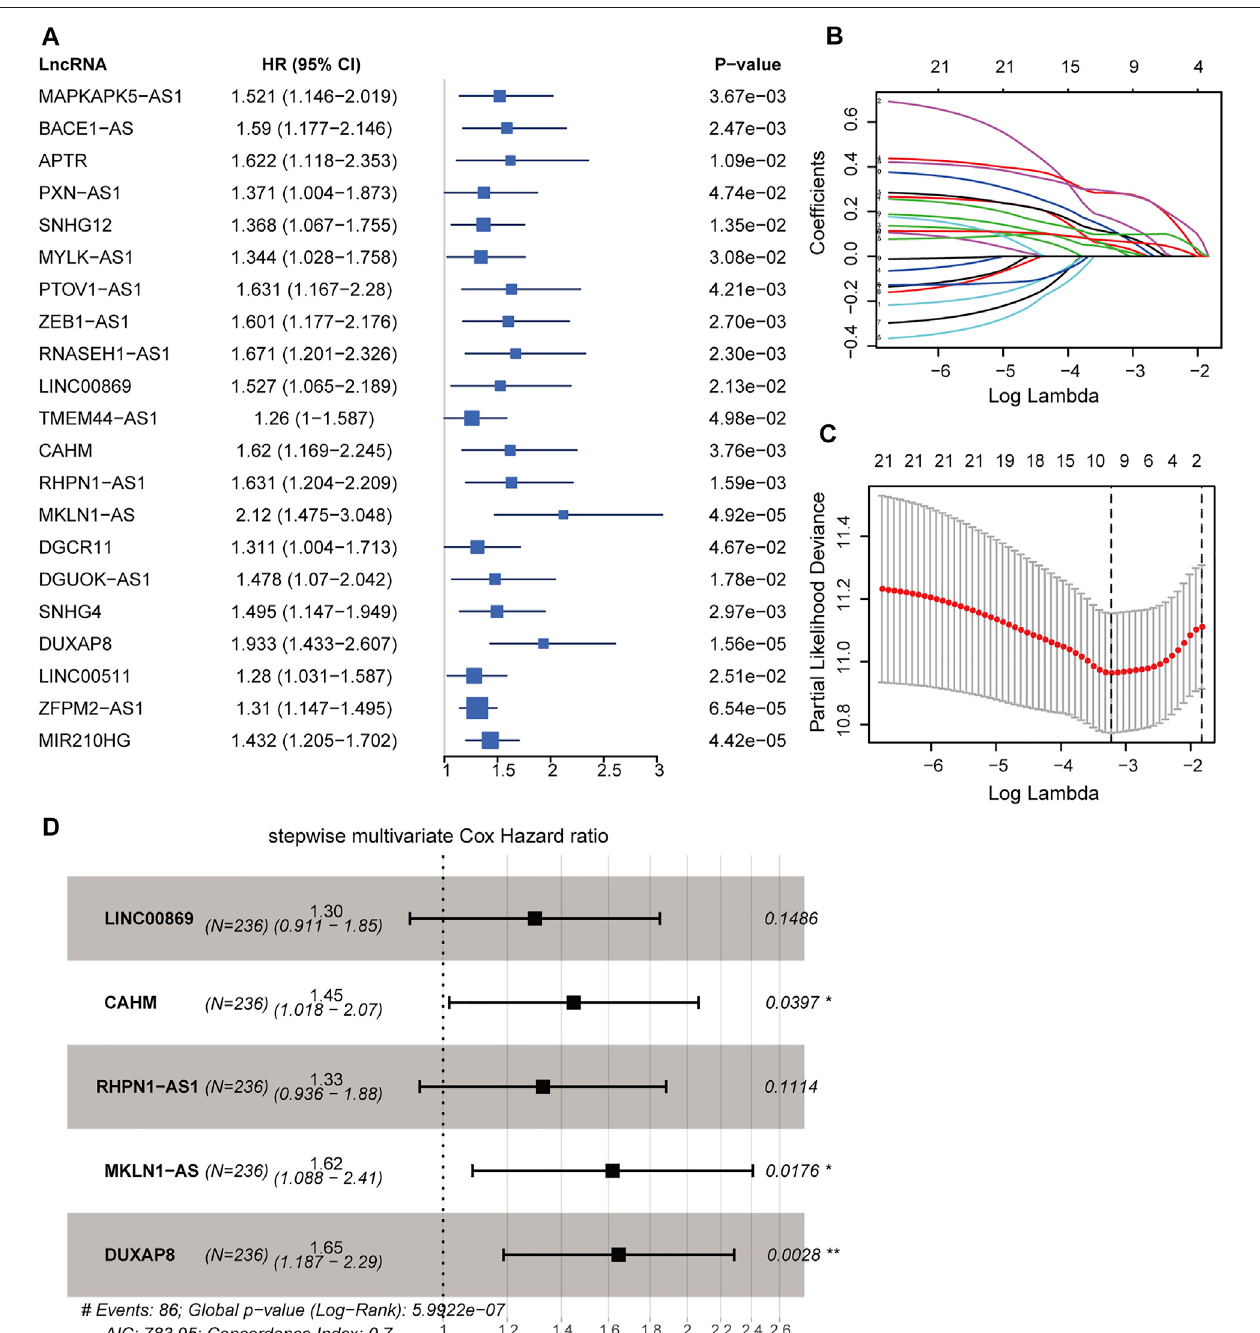
FIGURE 4 | Construction of hypoxia-related lncRNA signature in the training dataset. (A) Forest plot of 21 signi fi cant prognostic lncRNAs determined by the univariateCoxregression. (B) LASSOpenaltycoef fi cientsoftheabove21prognosticlncRNAs. (C) Cross-validation oftheLASSOCoxregressionmodel,theleftvertical dashed line represents the “ lambda. min ” standard. (D) Forest plot of the optimal model determined by the stepwise multivariate Cox analysis according to the minimal AIC value (783.95). LASSO: least absolute shrinkage and selection operator. AIC: Akaike information criterion. ***, p < 0.001; **, p < 0.01; *, p < 0.05.